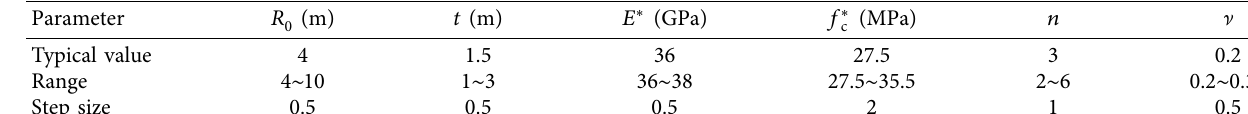
Table 1: Calculation parameters of FGL.